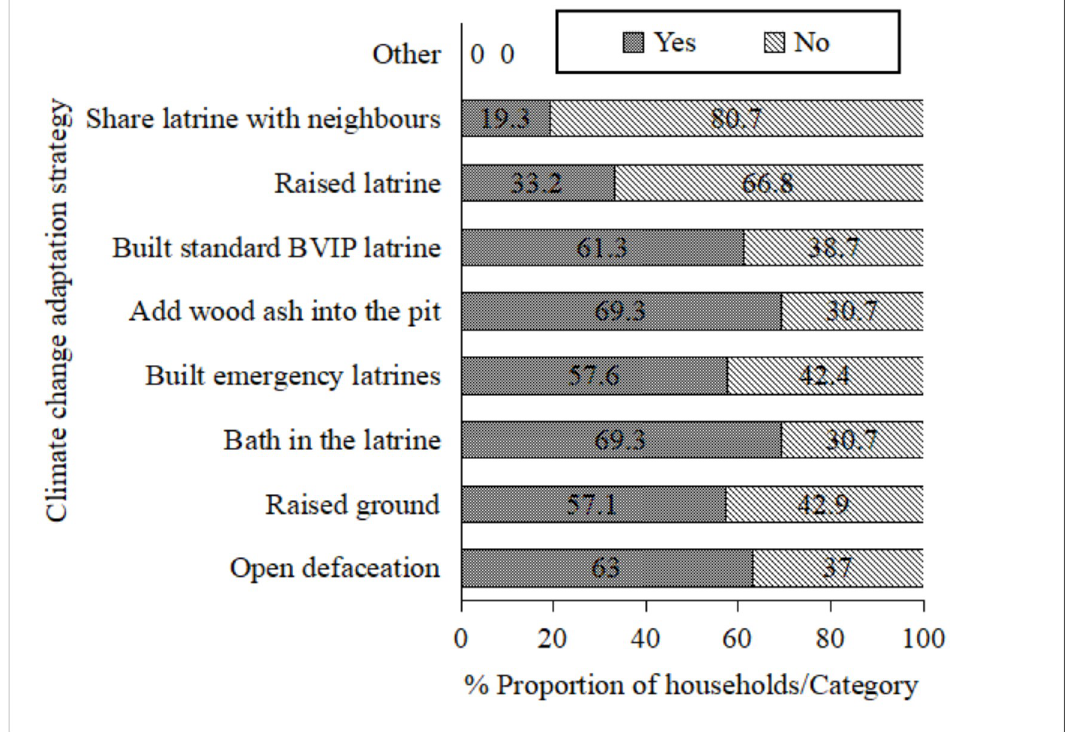
Fig 6. Reported adaptation strategies (survey) of household BVIP latrines to climate change in Mbire district, northern Zimbabwe, 2021 (n = 238).